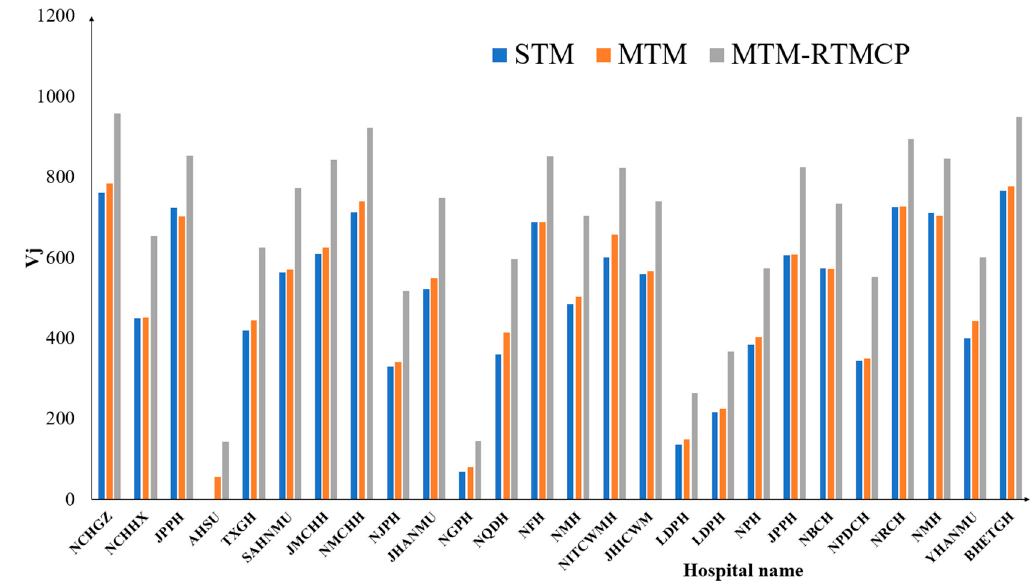
Figure 9. A variance bar chart of V